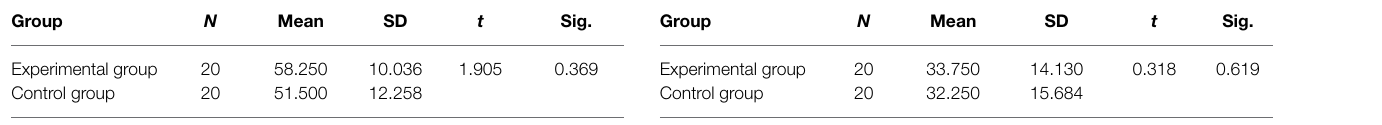
TABLE 1 | Analysis of the independent sample t -test of the pretest of two groups. Group N Mean SD t Sig. Experimental group